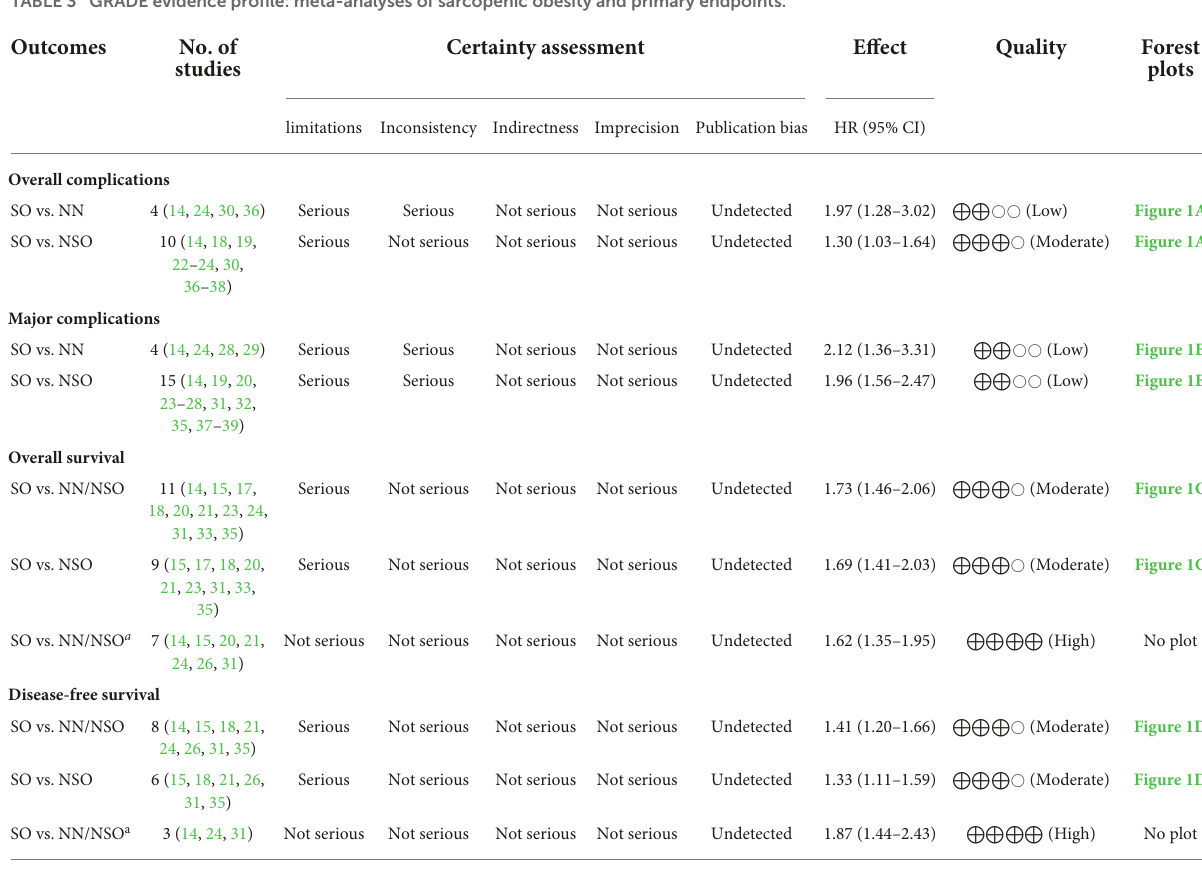
TABLE 3 GRADE evidence profile: meta-analyses of sarcopenic obesity and primary